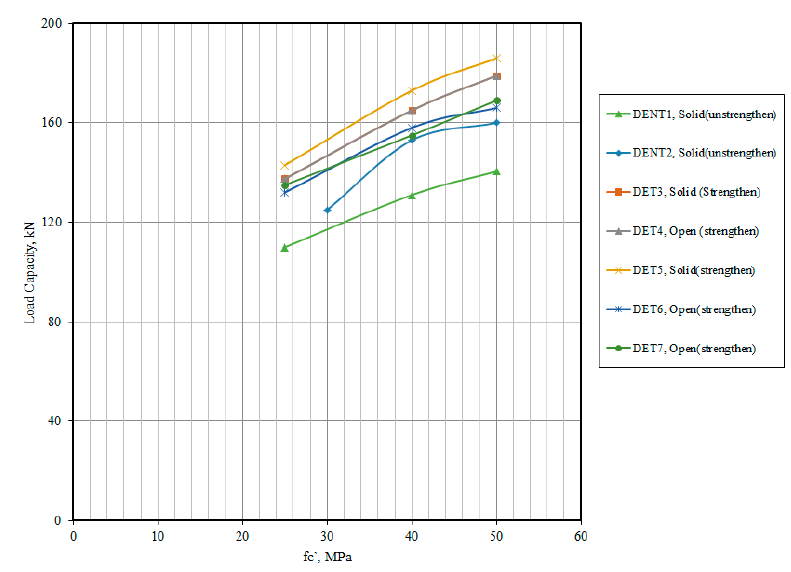
Figure 18. Load carrying capacity versus concrete compressive strength curves.